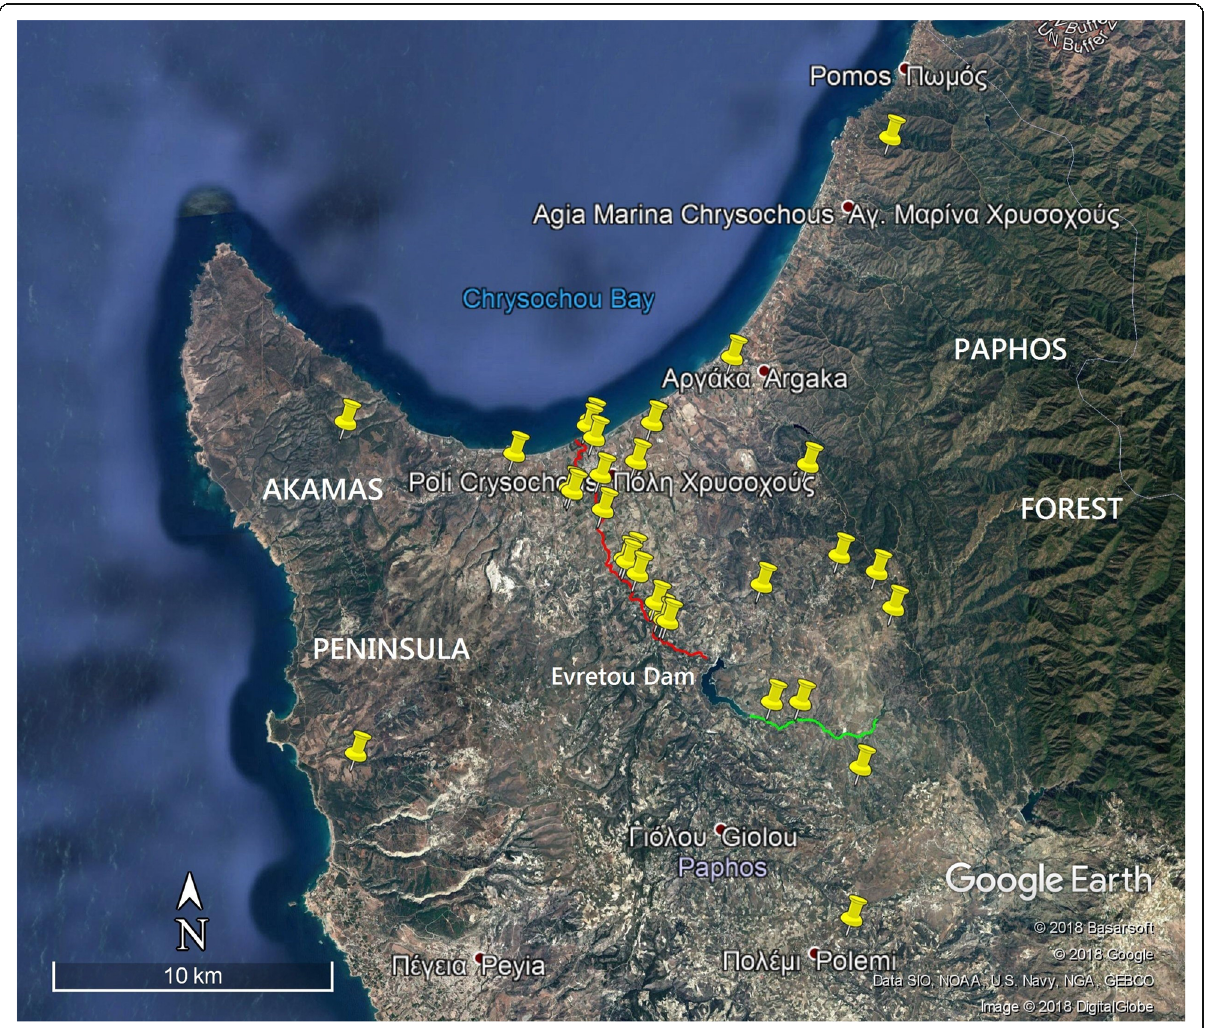
Fig. 1 The study area in northern Paphos district: Polis Chrysochous municipality (35°02 ’ N, 32°26 ’ E) and surroundings, bordered by Akamas Peninsula in the west and Paphos Forest (Troodos Mountains) in the east. The Chrysochous River is highlighted in red. The lower section of the Stavros tis Psokas River, which flows into the Evretou Reservoir, is highlighted in green. The yellow pin markers represent the locations of the recorded M. l. lebetina specimens from this study, with one individual from near Kakopetria (Nicosia district) not